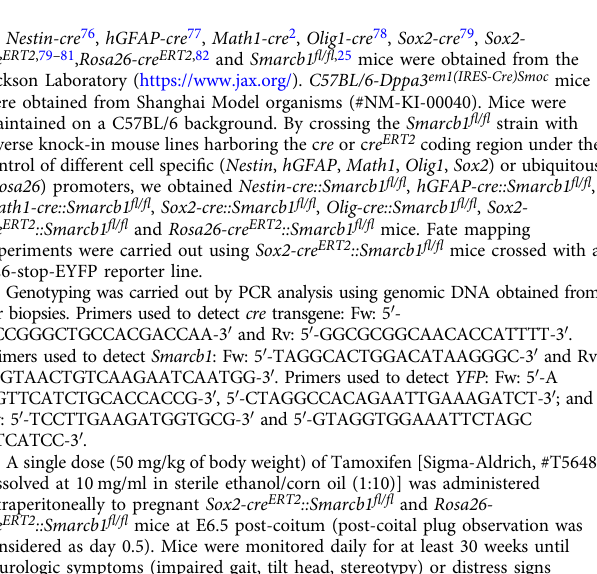
Fig. 7 Counteracting epigenetic imbalance in MYC tumors through targeted therapy. A Eight human RT cell lines (3 for SHH and 5 for MYC subgroups) was tested for viability after 6 days decitabine (DAC) treatment (1 µ M). A remarkable decrease in cell viability was observed in both subgroups, though the effect on MYC cells was more pronounced. (Unpaired-t-test, two-tailed, * p = 0.064). For each box, the lower and upper bounds represent the 25th and 75th percentiles; the center corresponds to the 50th percentile (median). The whiskers go down to the smallest value and up to the largest. B Graph depicts the cell number of DAC-treated BT16 (ATRT-MYC) cells over time. n = 2/3 technical replicates. Mean ± SD is shown; gray dots indicate individual values. C Overrepresented functional categories of up- and downregulated DEGs of DAC-treated BT16 cells over 14 days compared to untreated